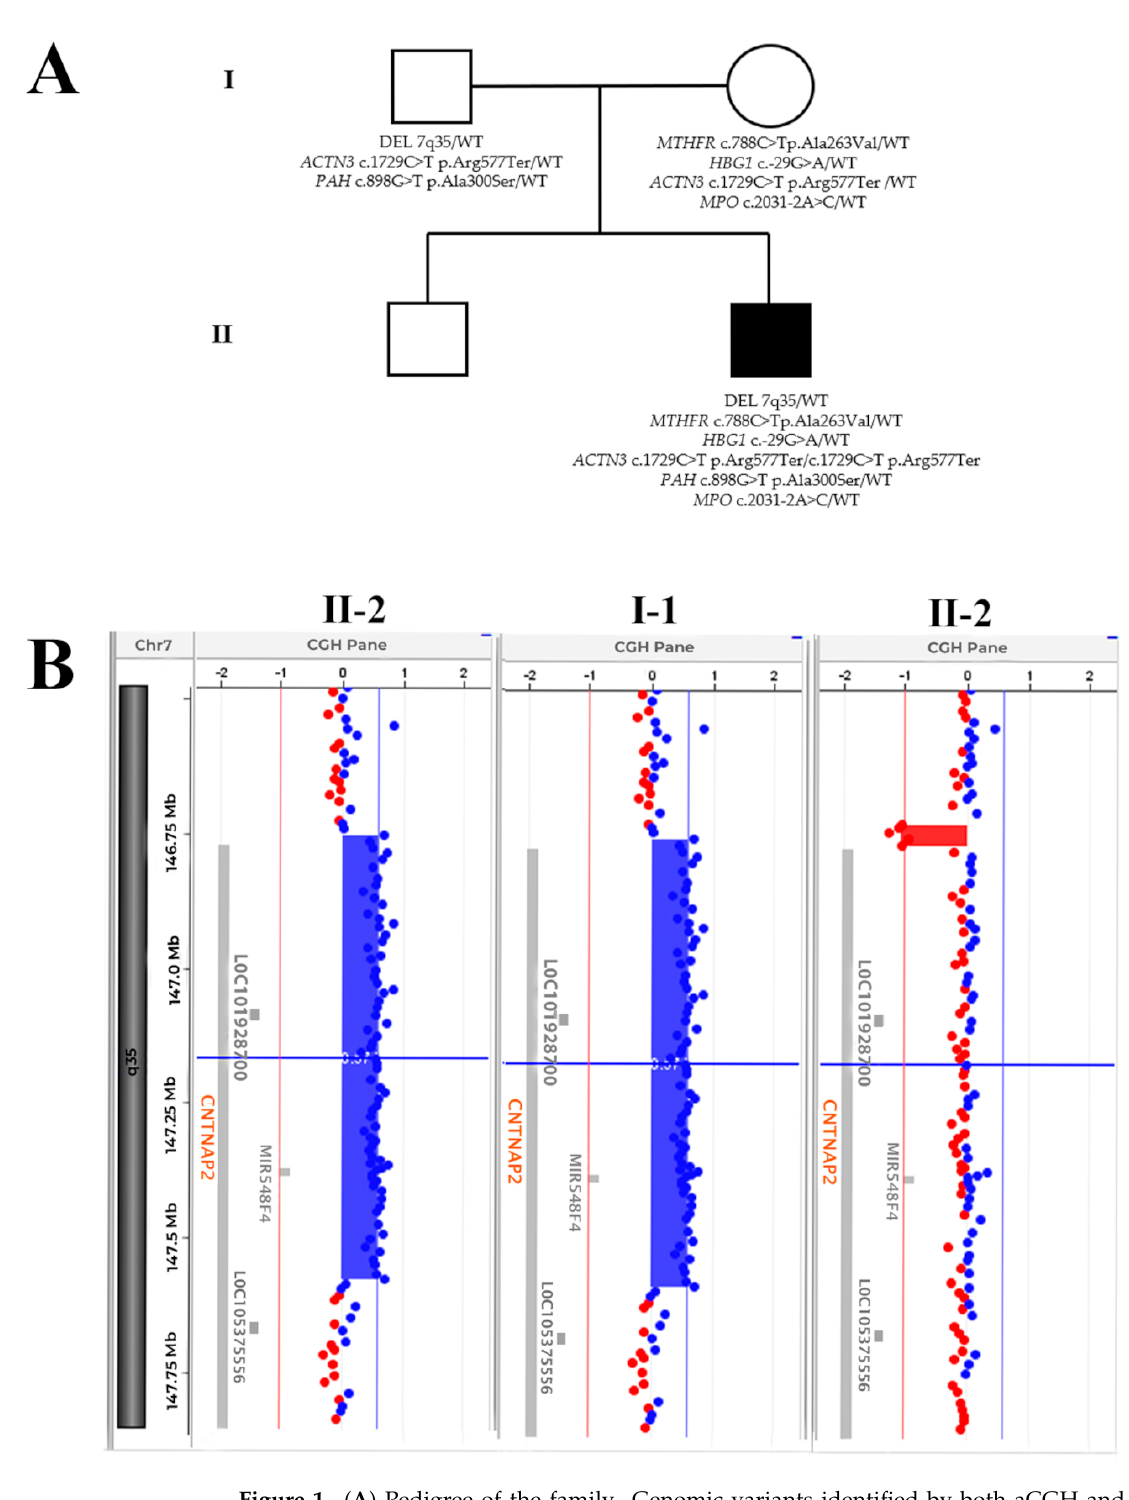
Figure 1. ( A ) Pedigree of the family. Genomic variants identified by both aCGH and WES are reported for each member of the family trio. ( B ) a-CGH profile of chromosome 7. This analysis shows a heterozygous duplication in 7q35 of 883.54 kb involving CNTNAP2, LOC101928700 , MIR548F4 in the proband (II-2) and in the father (I-1), CGH analysis. The deletion was not observed in the mother (I-2). The duplication, when present, is indicated by a blue